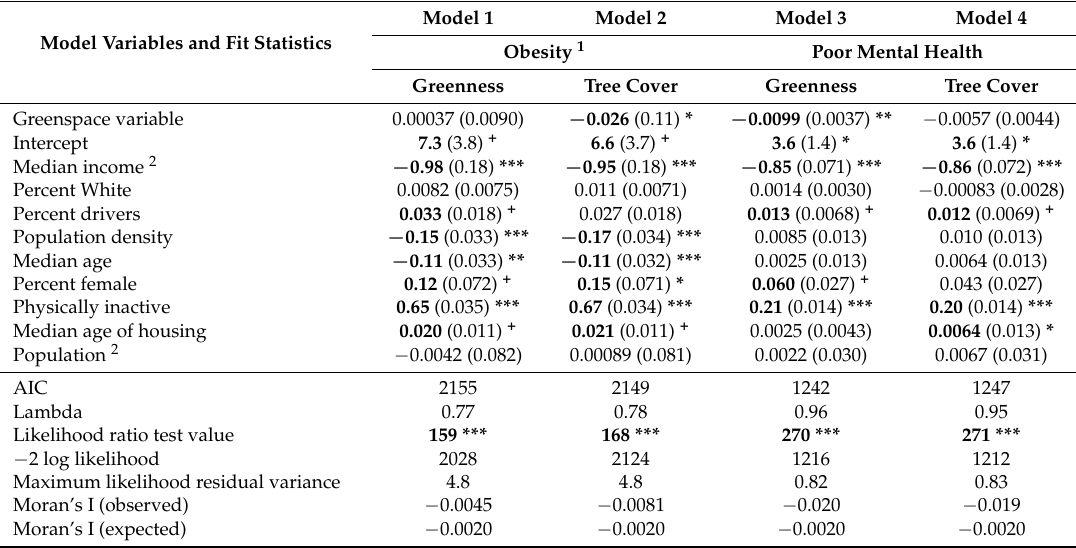
Table 4. Four models testing the greenspace-health relationship at a city scale while adjusting for spatial and confounding